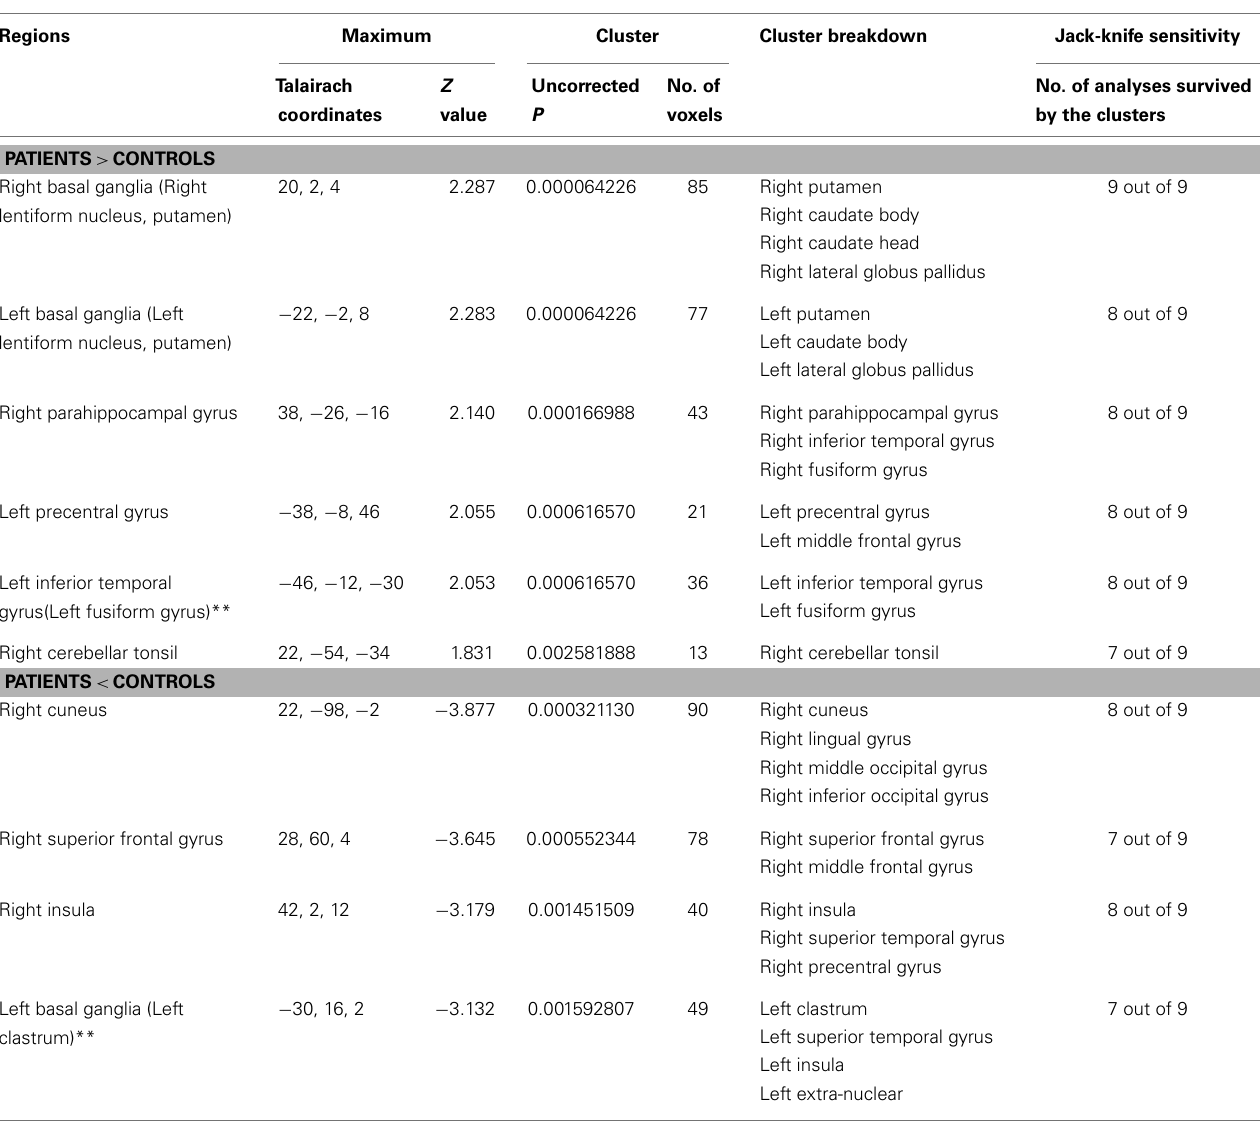
Table 3 | Gray matter differences between patients and healthy controls